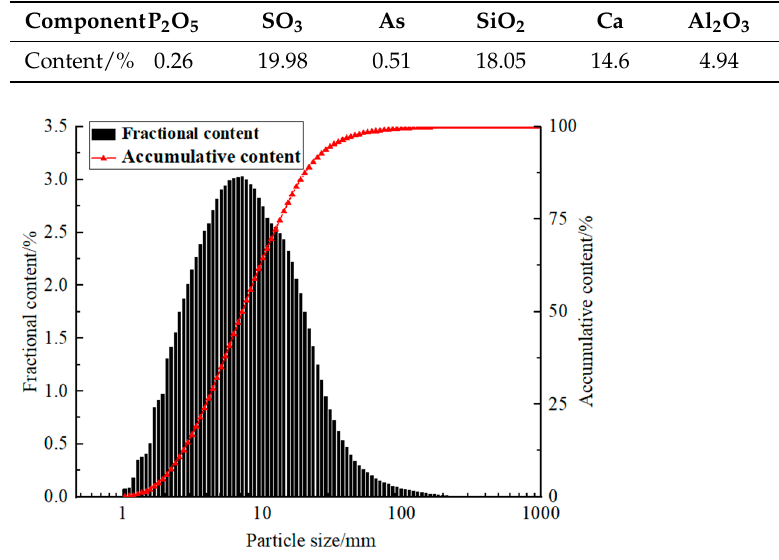
Figure 1. Particle size composition of neutralizing slag in backfill aggregate.